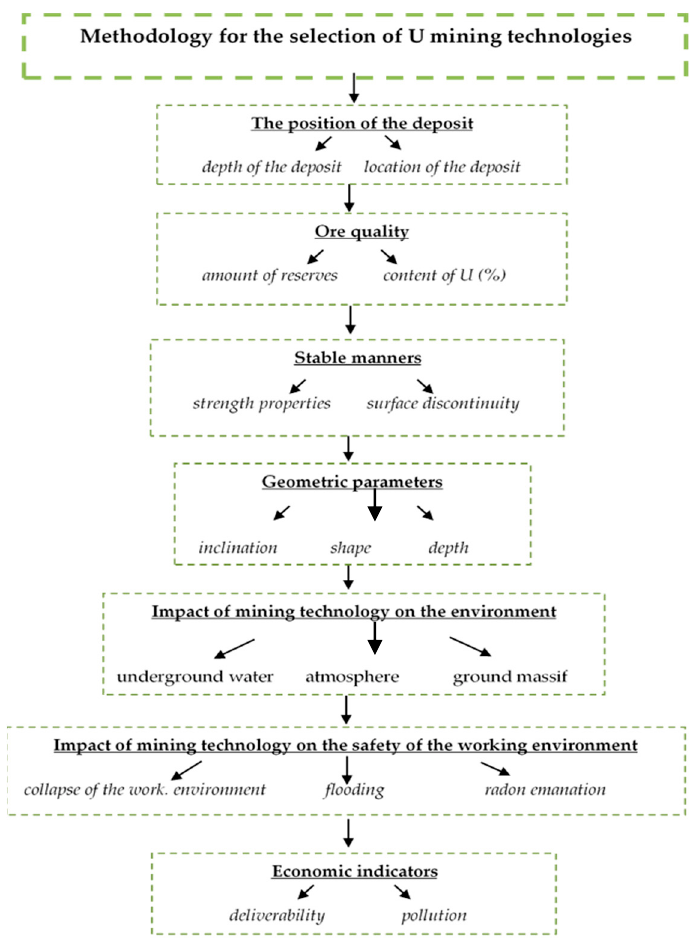
Figure 4. Methodology for selecting the technology of uranium mining in the deposit of Kuriskova.